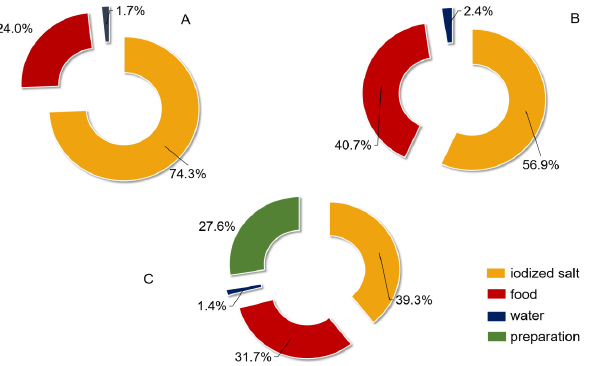
Figure 4. Contribution of iodine from different sources for different populations. (A) children; (B) adults; (C) pregnant women.